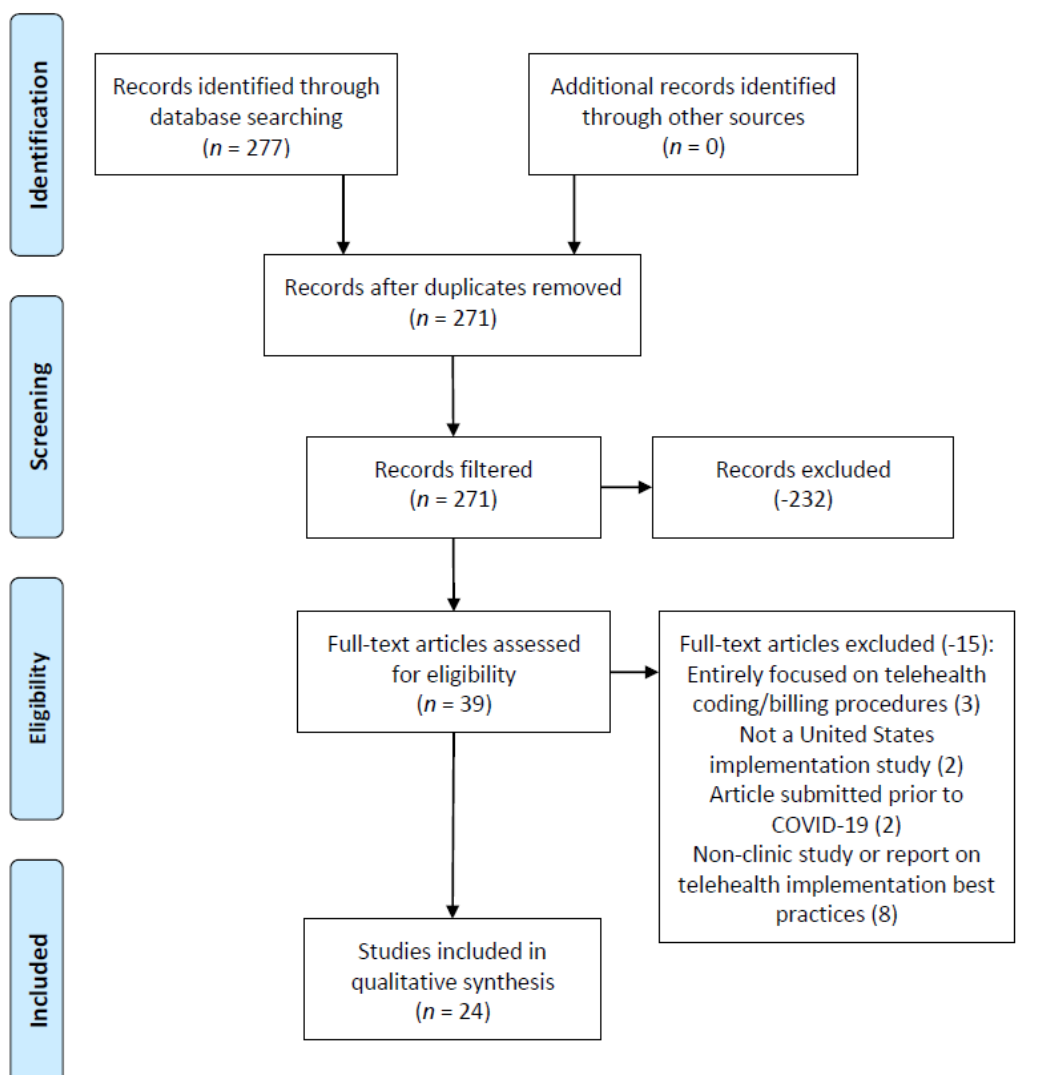
Figure 1. Preferred reporting items for systematic reviews and meta-analysis (PRISMA) figure that demonstrates the study selection process.